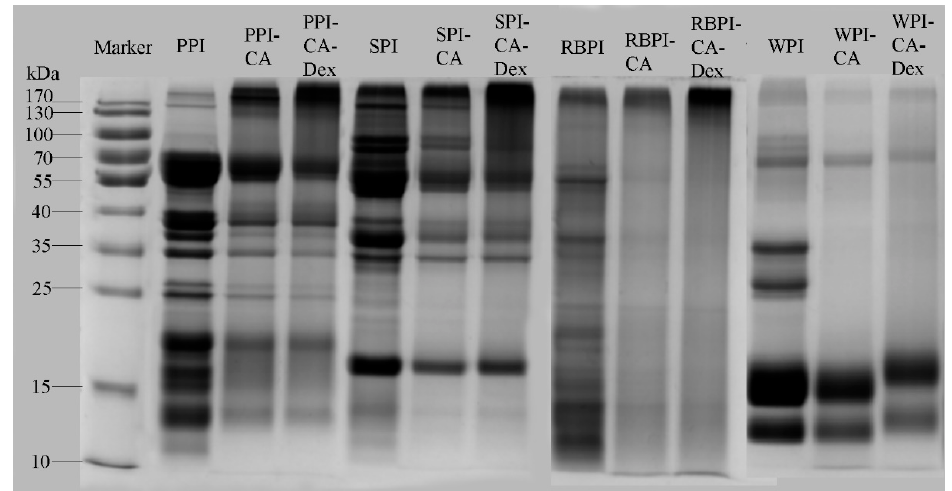
Figure 1. The Sodium Dodecyl Sulfate-Polyacrylamide Gel Electrophoresis (SDS-PAGE) gel electrophoresis spectrums of Native Protein (NP), protein-chlorogenic (PC) and protein-chlorogenic acid-dextran (PCD) samples.